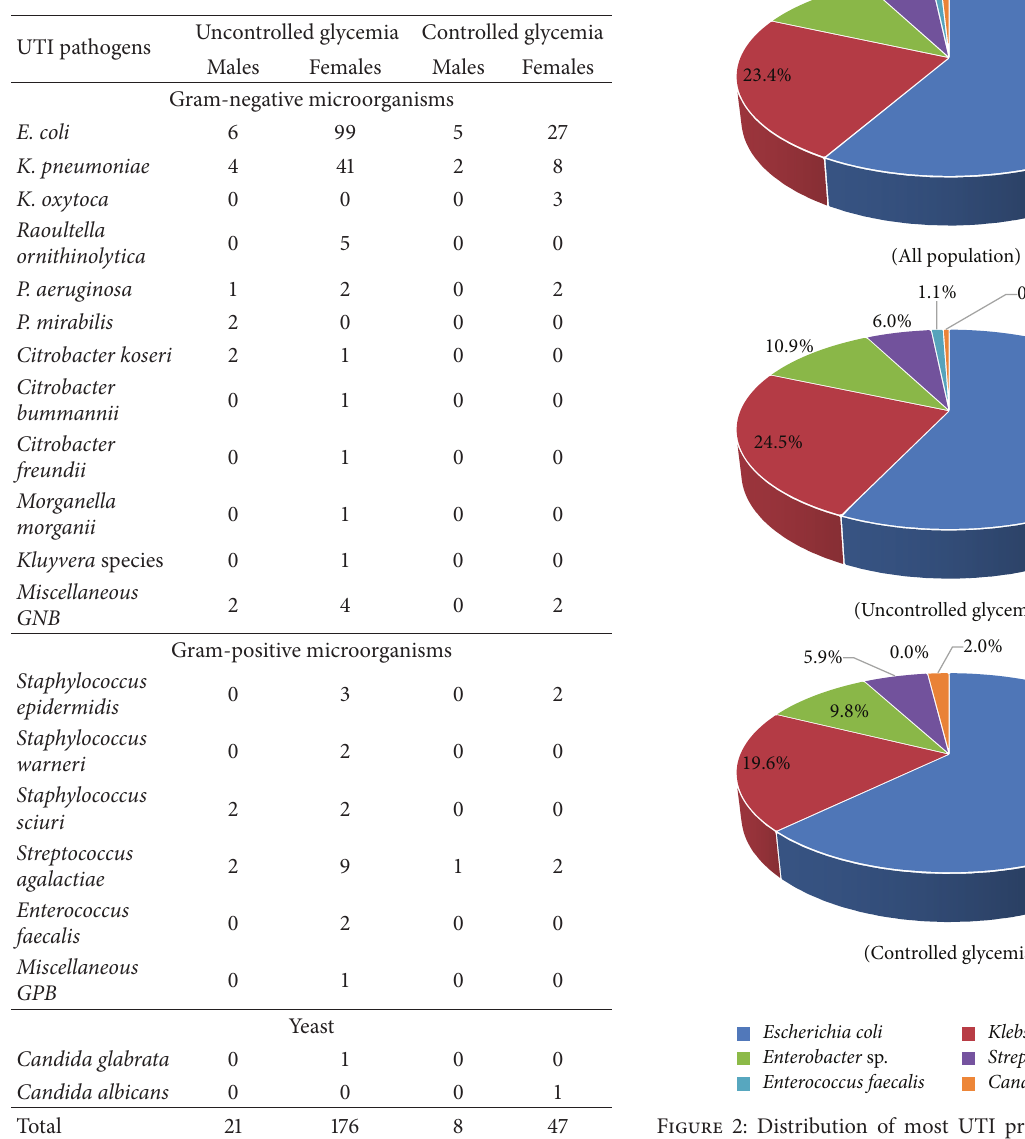
Table 3: Microbial uropathogens isolated from urine of our diabetic study population.